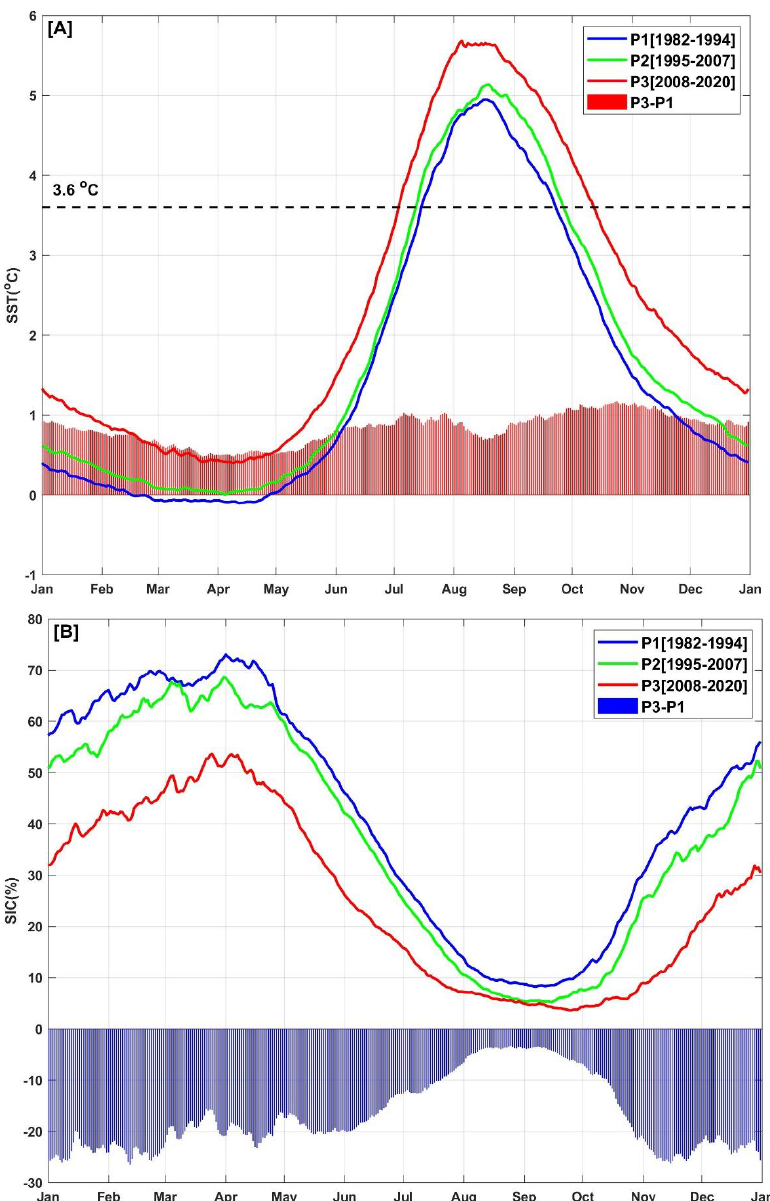
Figure 3. Average daily seasonal curves of ( A ) SST and ( B ) SIC over the whole Barents Sea for the periods P1 (1982 – 1994, blue line), P2 (1995 – 2007, green line), and P3 (2008 – 2020, red line). The red and blue bars in ( A , B ) indicate the daily increase/decrease of SST and SIC between P3 and P1. The seasonal curve changes demonstrate that the summer season began earlier and lasted longer, with SST increases exceeding 1 °C through October and November between P1 and P3, while the lowest SST increase (~0.55 °C) was found through March and April. The horizontal dotted black line in ( A ) represents the 3.6 °C threshold of SST.